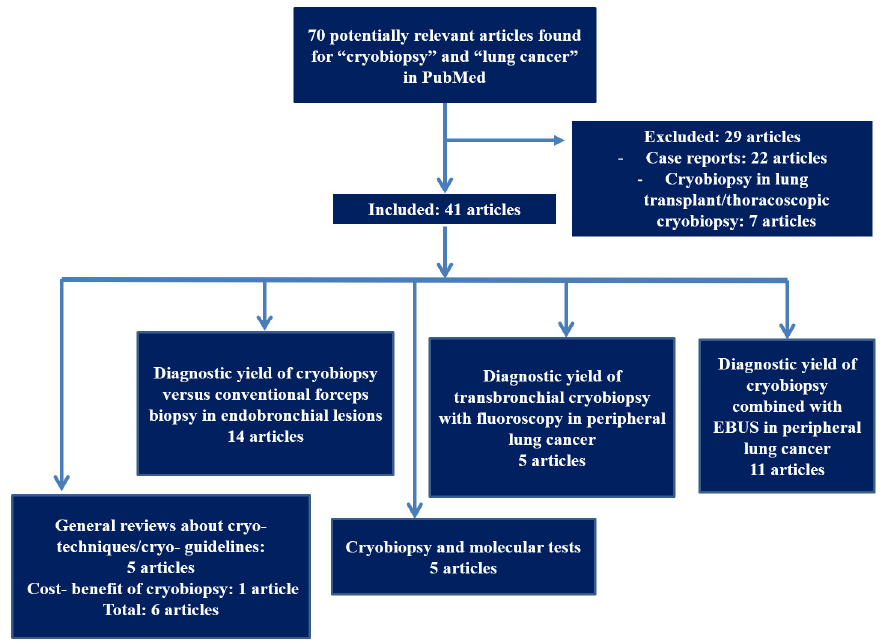
Figure 1. Flowchart of the search process for the review regarding cryobiopsy in lung